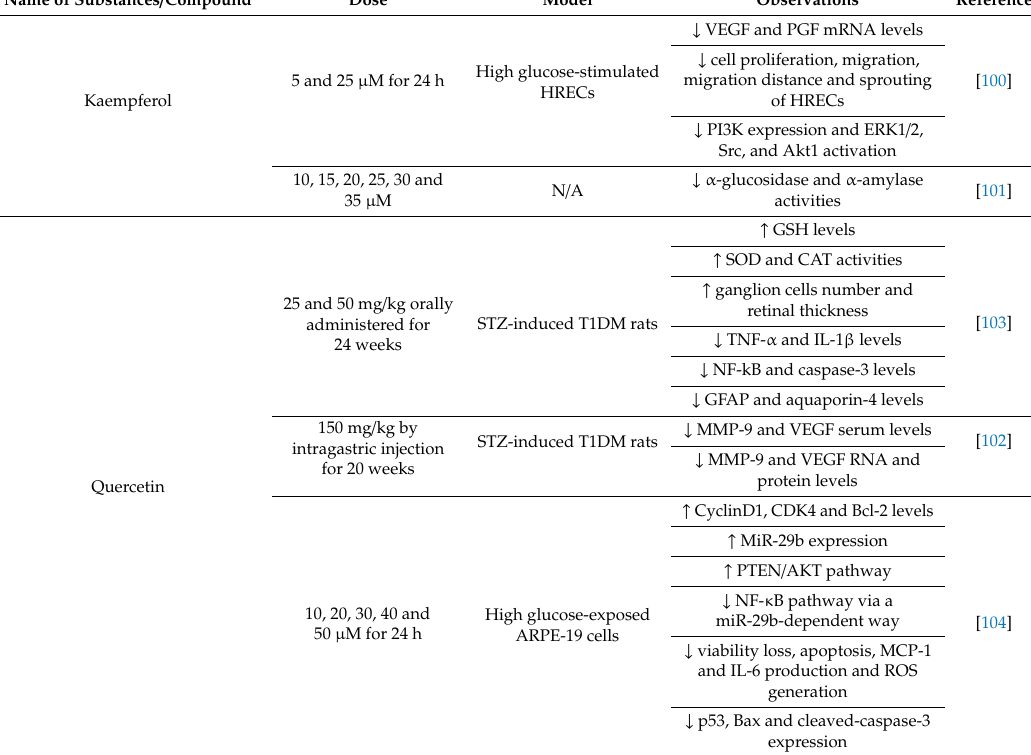
Table 5. E ff ects of flavonols on cellular and molecular mechanisms a ff ected by diabetic retinopathy. Name of Substances /